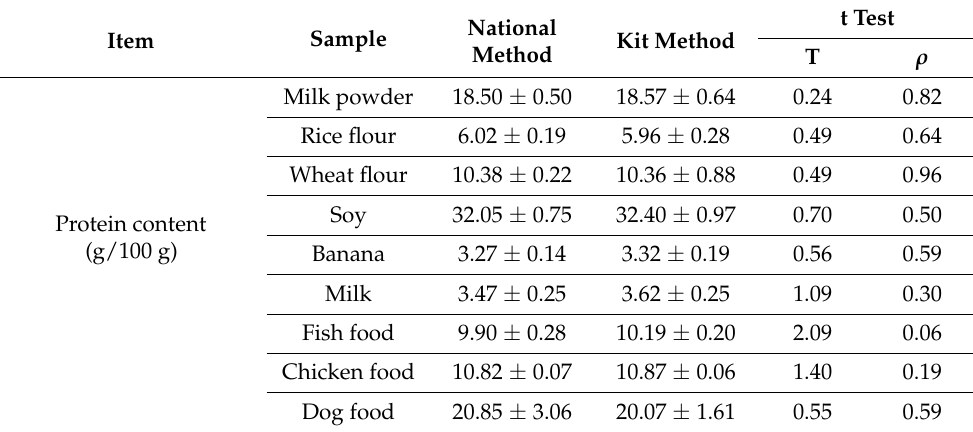
Table 5. Comparison of national method and ammonium ion test kit